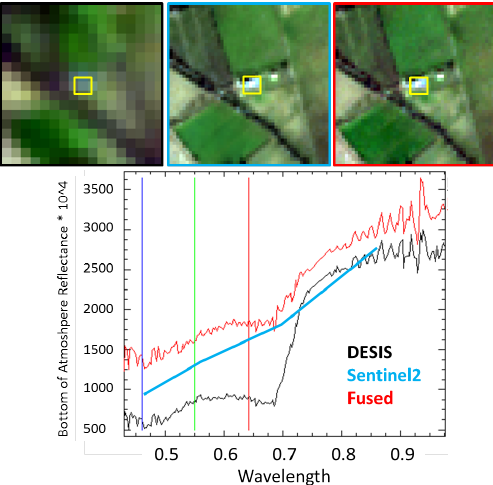
Figure 29. Image elements with low variance in the subset of interest, assumed to belong to homogeneous areas, reported in red ( a ). Spectral Angle between DESIS image upsampled to 10 m (nearest neighbor) and fused product ( b ). Areas with associated higher distortion usually contain mixed pixels, which exhibit different spectral features at different resolutions.